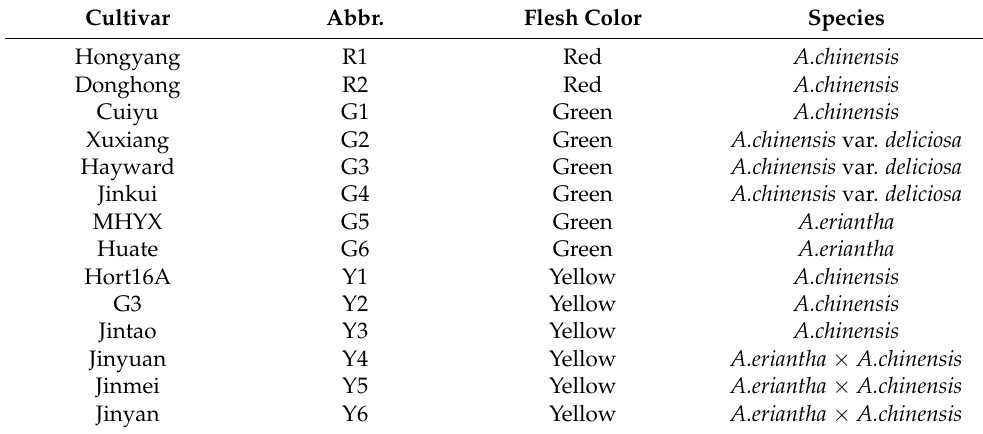
Table 1. Cultivars, species and flesh color of kiwifruits. Cultivar Abbr. Flesh Color